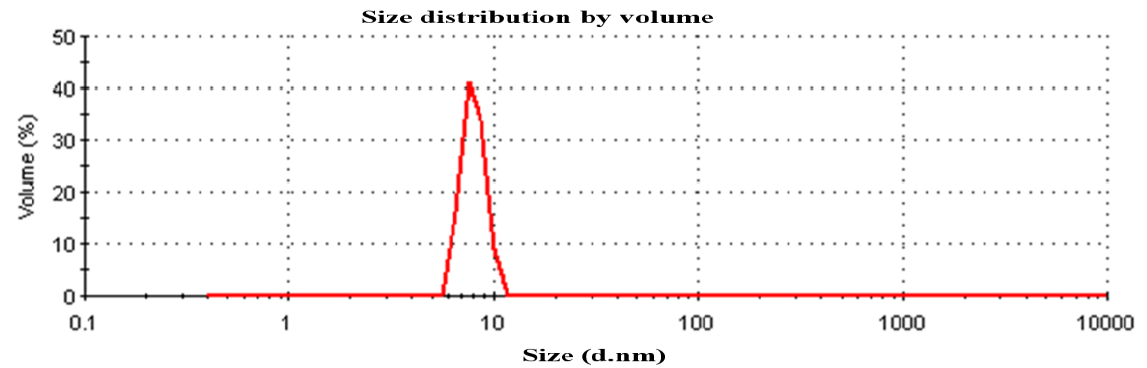
Figure 6. Particle size distribution of ZnO nanoparticles diluted with water and treated with ultra- sound for 5 min.